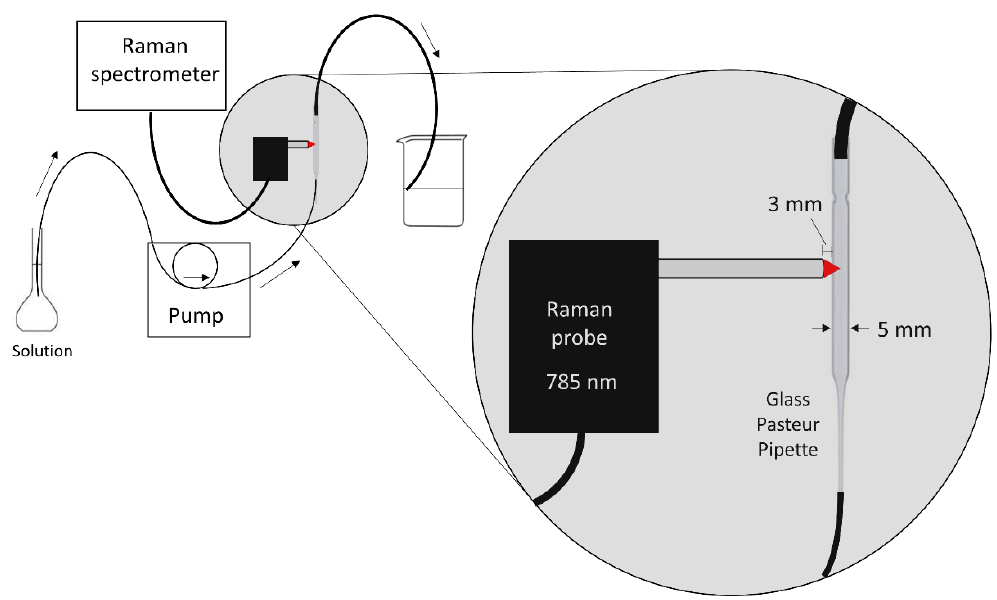
Figure 1. Homemade instrumental design for the flow system with Raman detection.